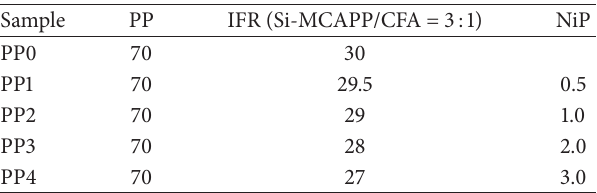
Table 1: Formulations of the flame retardant PP composites.